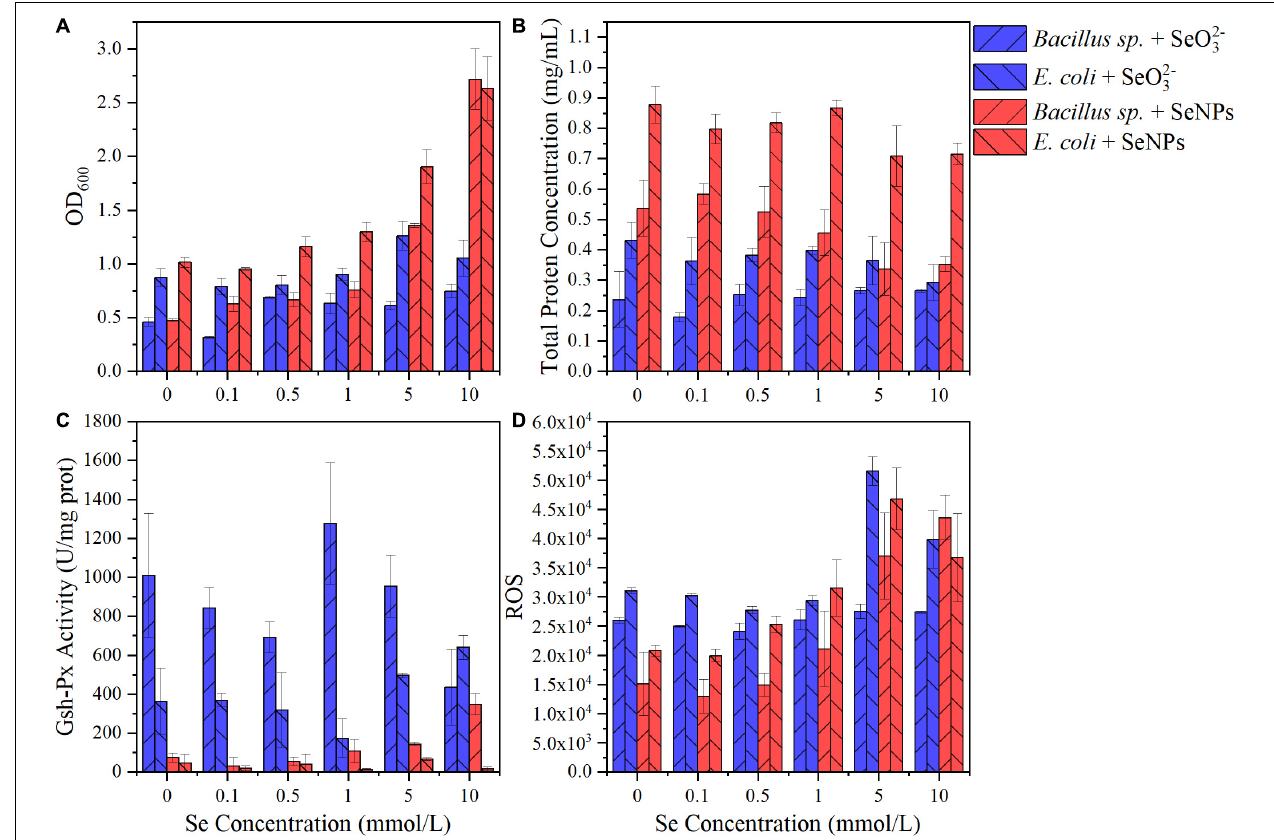
FIGURE 6 | Effects of selenium nanoparticles (SeNPs) and selenite (SeO 32 - ) on typical soil microorganisms. (A) OD 600 . (B) Total protein concentration. (C) Glutathione peroxidase (GSH-Px) activity. (D) Reactive oxygen species.